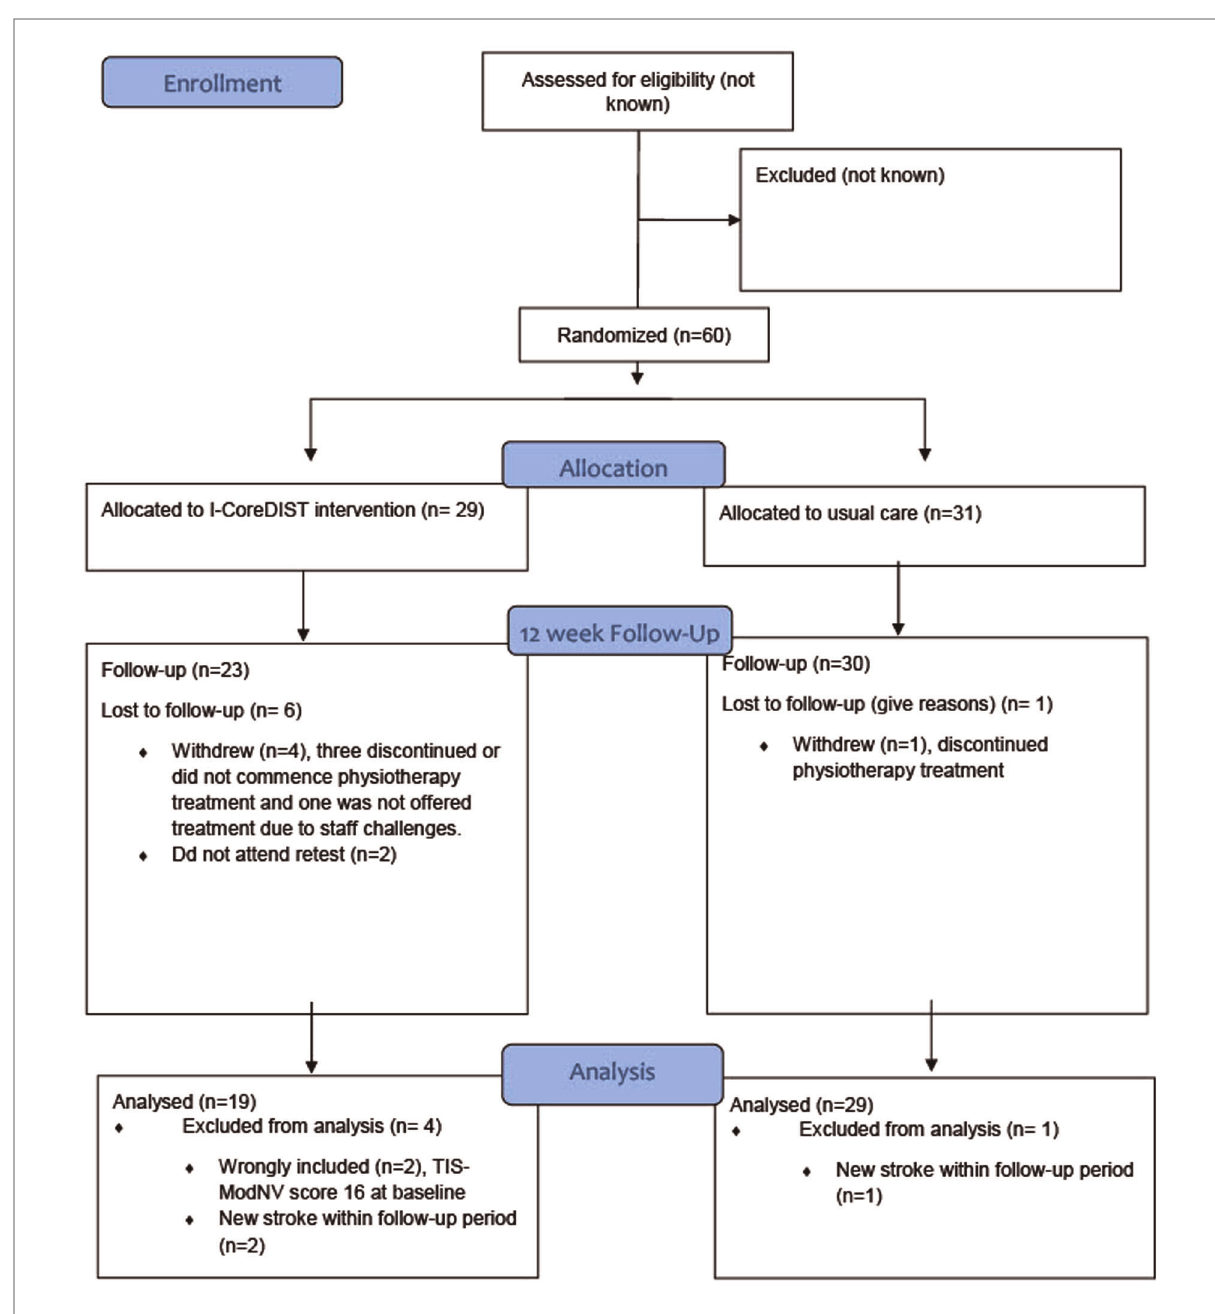
FIGURE 1 The fl ow of patients through the